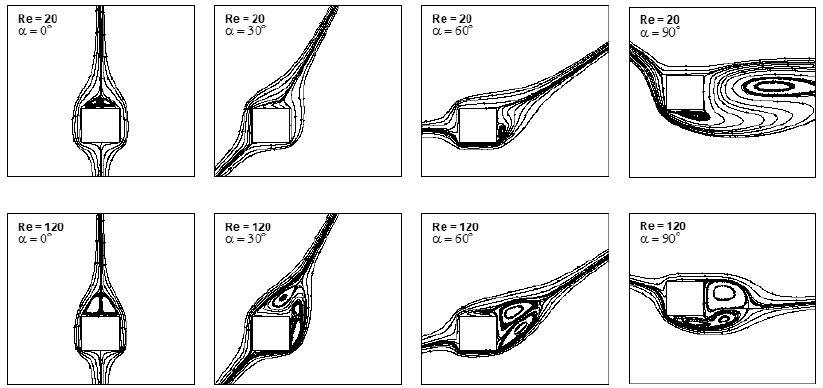
Figure 26. Mean/steady streamline patterns for Re = 20 and 120, 0° ≤ α ≤ 90° at Ri = 1.6.